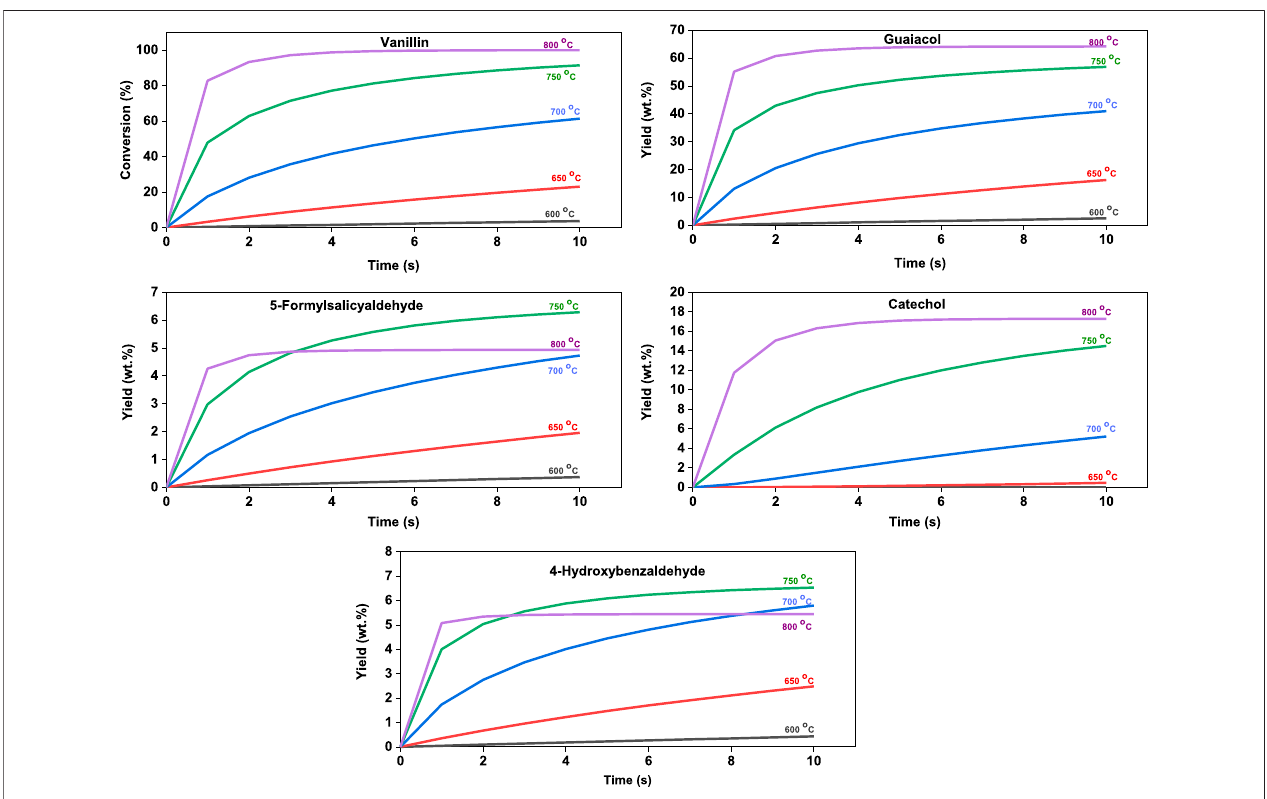
FIGURE 7 | Model time evolution pro fi les of vanillin and its primary pyrolysis products at different temperatures.